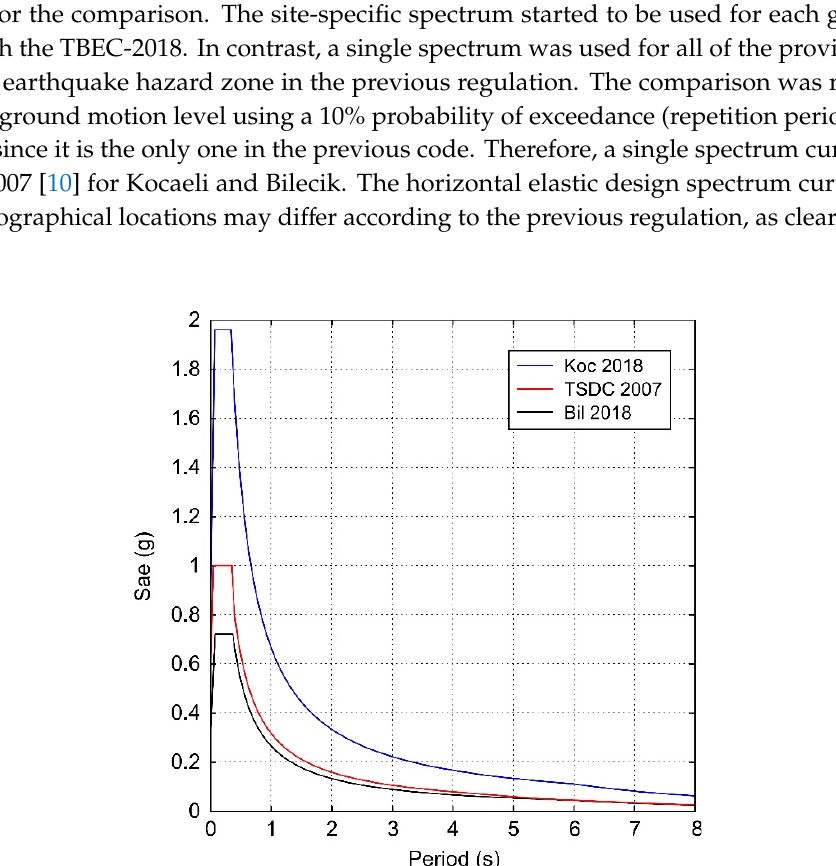
Table 11. Comparison of target displacements for damage estimation according to previous and updated codes. Province